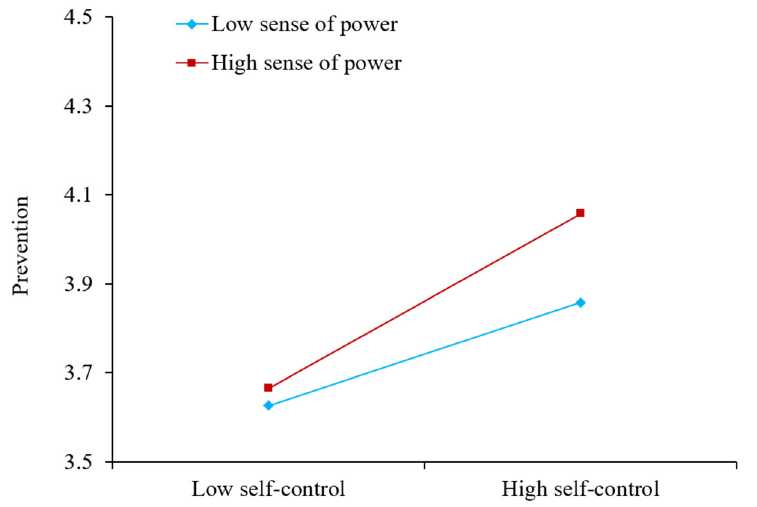
Figure 3. The moderating effect of sense of power in the relation between self-control and prevention focus.